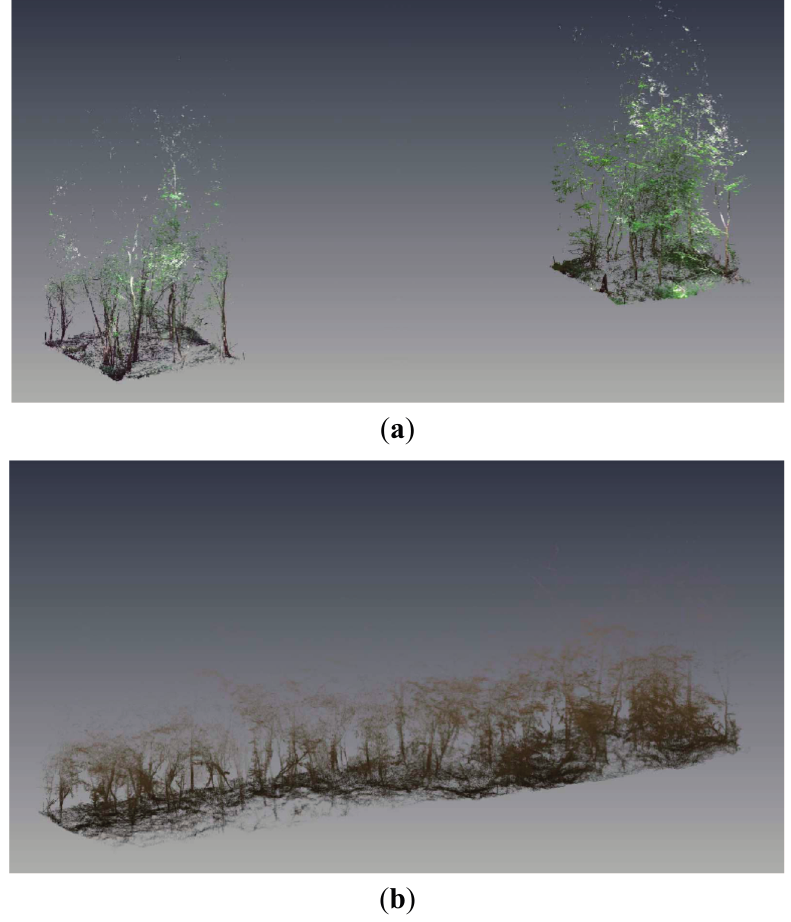
Figure 8. Point cloud spatial extent comparisons for ( a ) FARO—120 min and ( b ) ZEB1—10